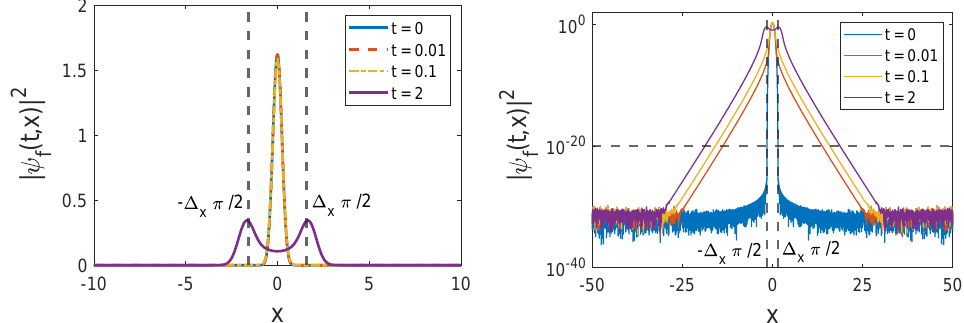
(cid:12) (cid:12) 2 (cid:12) (cid:12) ( t , x ) Figure 1. for the function with compact support f ( x ) = cos 8 ( x / ∆ x ) (with ∆ x = 1 and (cid:12) ψ f (cid:12) p 0 = 0) is shown for different values of t (in natural units ¯ h = c = m = 1). Left panel displays the plots in the usual (linear) scale and the right panel shows the same quantities with a logarihtmic scale. The horizontal dashed line indicates the numerical zero. The initial wavefunction has compact support (no density above the numerical zero), whereas beyond the light-cone propagation appears for times t >